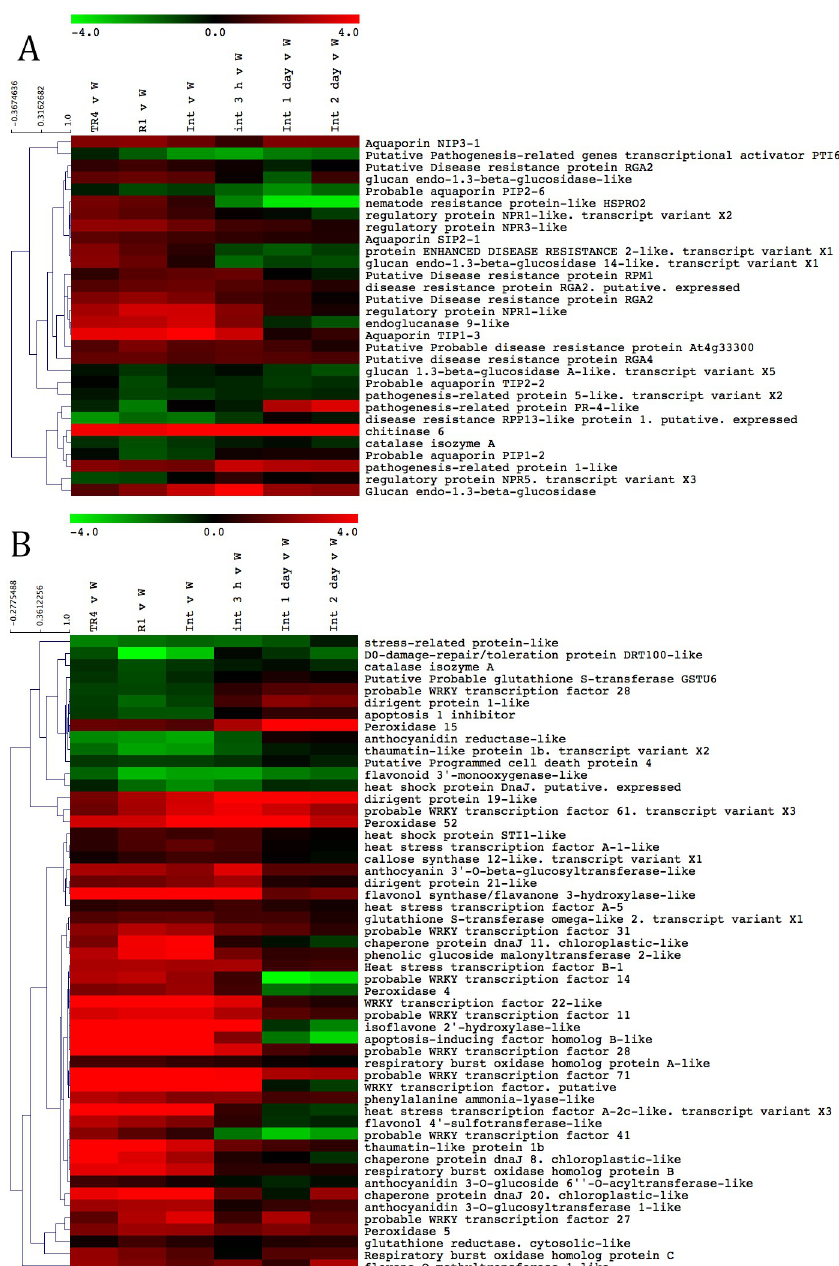
Fig 4. Transcriptional analyses of pathogenesis related genes in the interactions between Cavendish ‘Grand Naine’ and R1, F . odoratissimum TR4 and the challenge inoculation R1 + TR4. Hierarchical clustering analysis of representative potential pathogenesis related genes (Panel A) and hypersensitive response genes (Panel B). The heat plots represent significant (P < 0.05) average expression differences between the water control and TR4, R1 and R1 + TR4 at 0, 3 hours, 1 day and 2 days after inoculation. Bars represent upregulated genes (red) and downregulated genes (green).